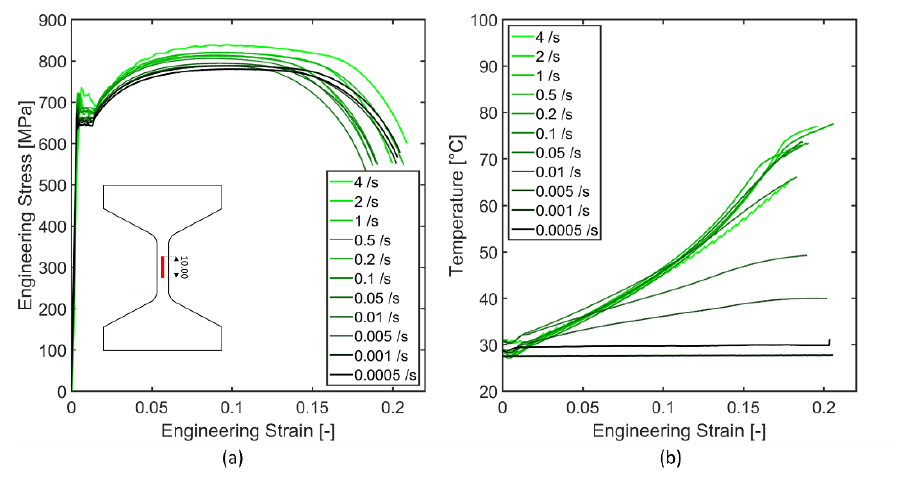
Fig. 2. (a) Engineering stress-strain curves from uniaxial tensile experiments on DP800 at strain rates from 0.0005/s to 4/s. The inset of the UT shows the location of the temperature measurement (b) Evolution of specimen surface temperature as a function of engineering strain.